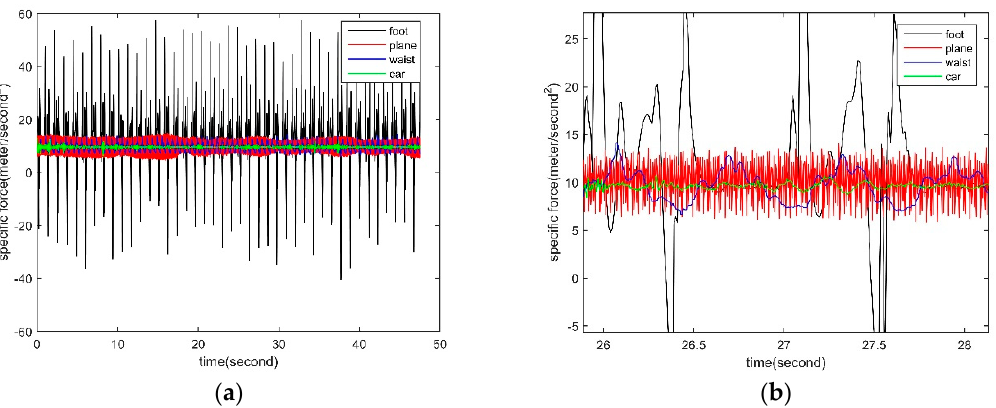
Figure A3. Line motion data for different carriers. ( a ) Specific force from four different carriers for car, plane, foot and waist; ( b ) Partial enlarged detail for ( a ).